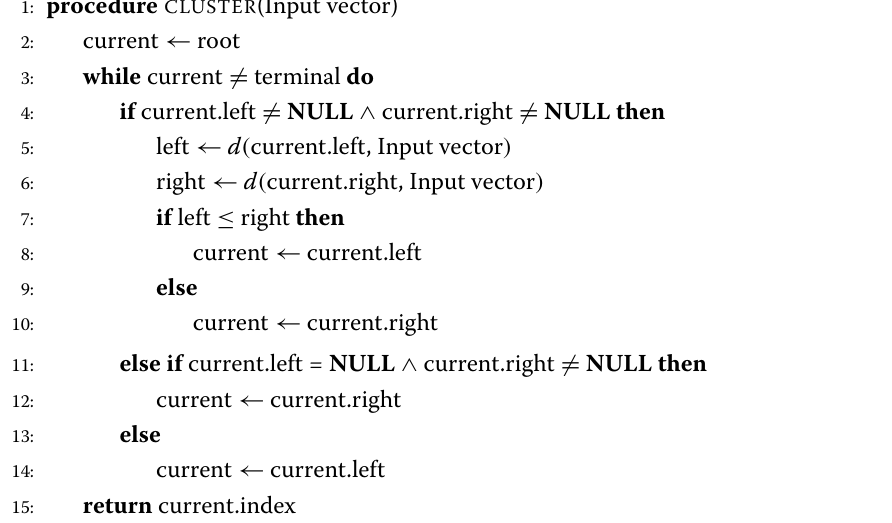
Algorithm 5 Clustering data with Neural N-Tree